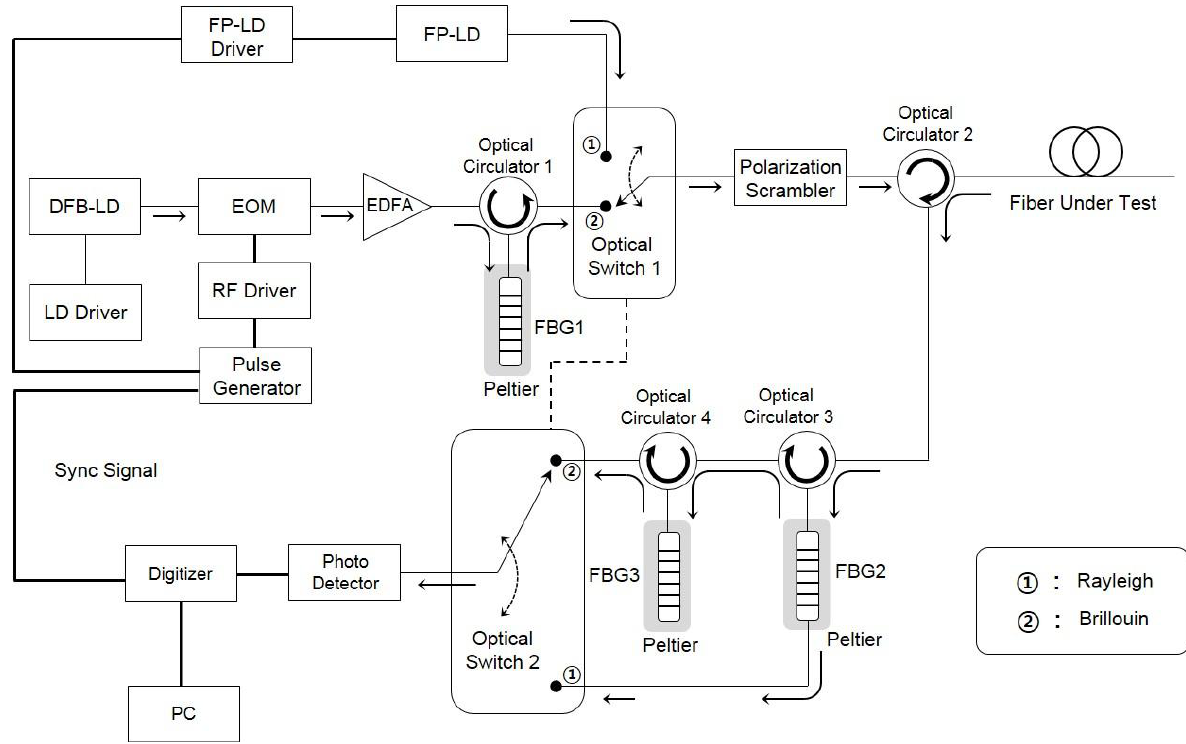
Figure 4. Schematic diagram of the developed OTDR and BOTDR